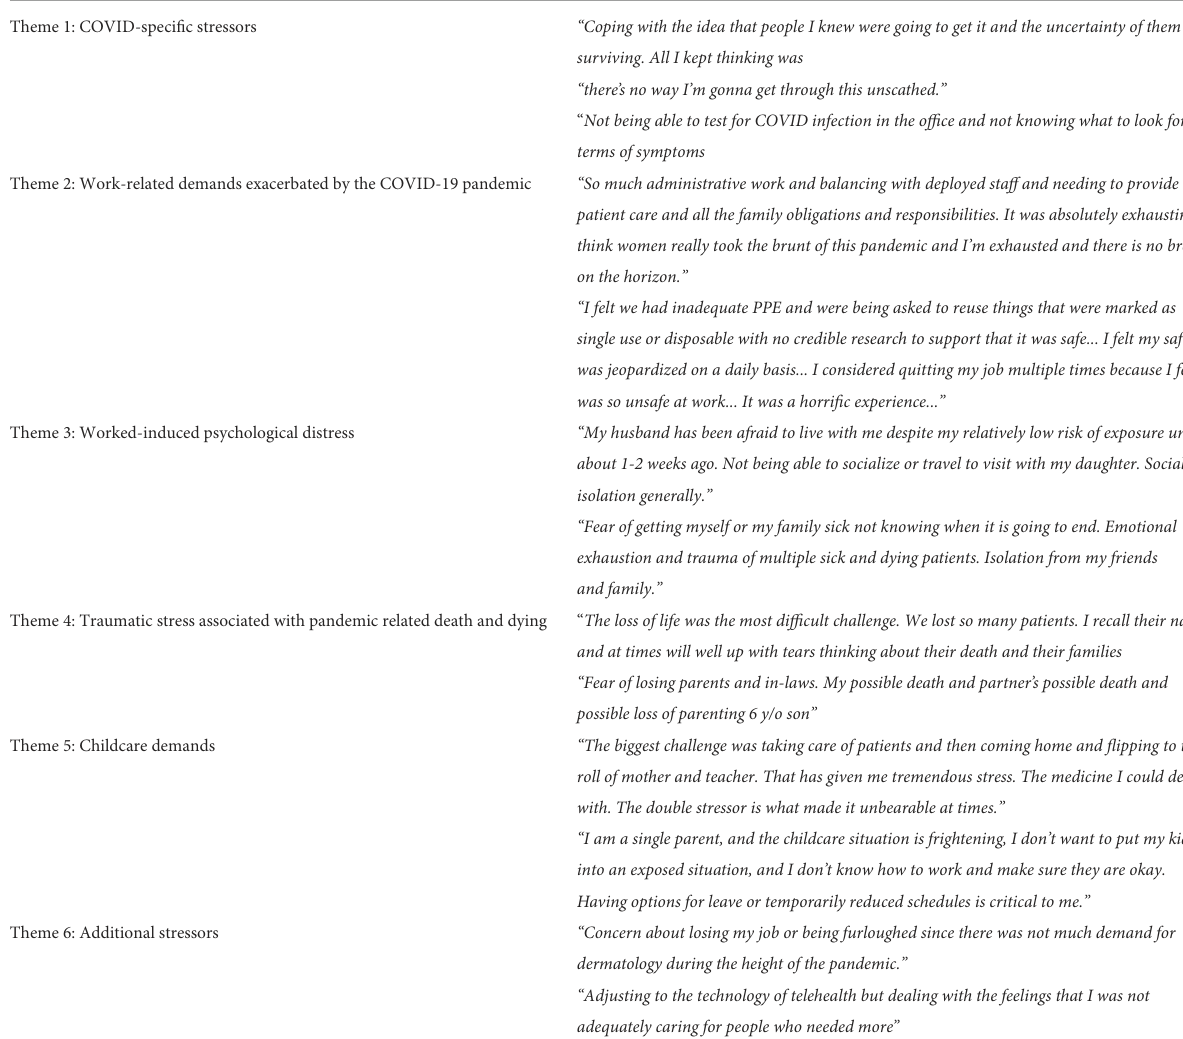
TABLE 4 Themes for